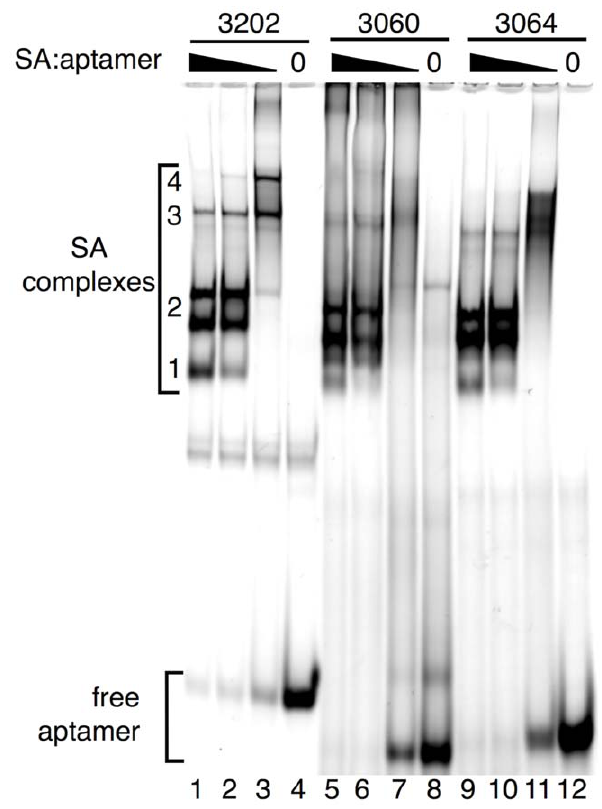
Figure 3. Formation of 3 9 -biotinylated DNA aptamer multimers by incubation with streptavidin. The indicated 5 9 -fluoresceinated, 3 9 -biotinylated DNA aptamers (lanes 4, 8, 12) were folded and then incubated with different amounts of streptavidin to produce multimeric aptamer complexes. Aptamer:streptavidin concentration ratios were 1:1 (lanes 1, 5, 9), 4:1 (lanes 2, 6, 10), and 20:1 (lanes 3, 7, 11). Mobilities of aptamer monomer and complexes containing one to four aptamers (1– 4; see Fig. 1C) are indicated. Note that complexes with two bound aptamers display two distinct mobilities due to cis vs. trans binding arrangements on the streptavidin